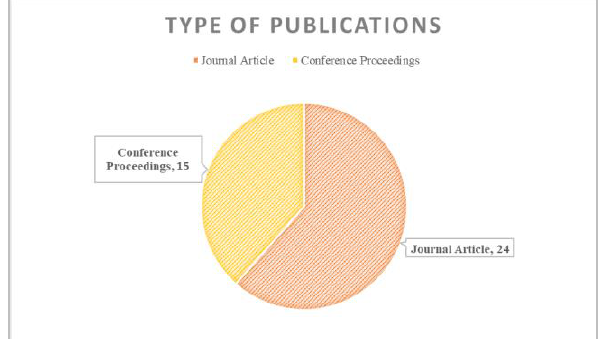
Figure 2 . An Overview of Type of Publication.